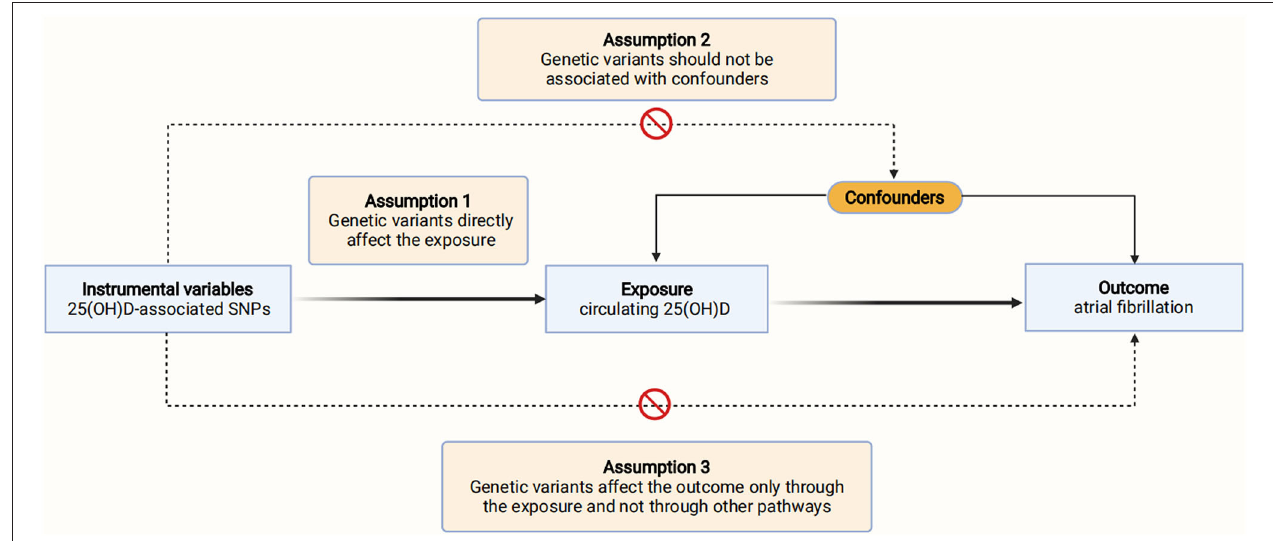
FIGURE 1 | Schematic diagram of the Mendelian randomization assumptions. AF, atrial fibrillation; SNPs, single-nucleotide polymorphisms; 25(OH)D, 25-hydroxyvitamin D.